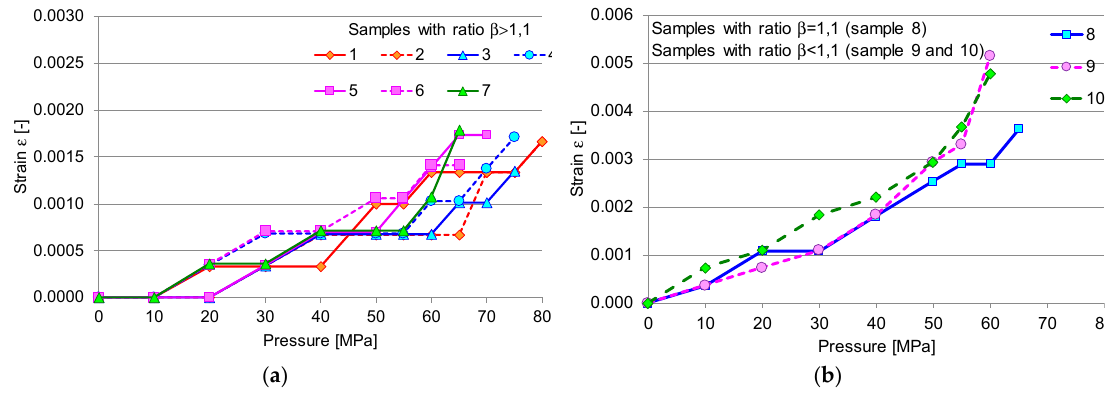
Figure 6. Variation of radial strain with increasing internal pressure: ( a ) for samples (1–7) with diameter ratios over 1.1; ( b ) for samples with an equal diameter ratio (sample 8) or ratios less than 1.1 (samples 9 and 10).